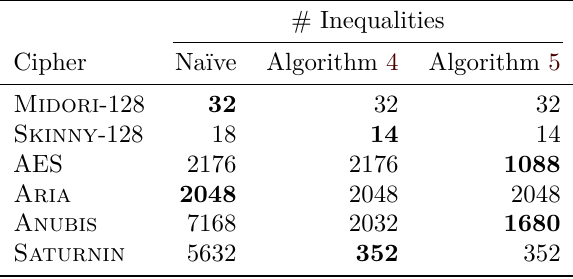
Table 8: Number of inequalities to model a diffusion matrix for MILP without dummy variables with the naïve way, and with the two algorithms developed in this section. A description of the linear layers of the three last ciphers can be found in Appendix F.